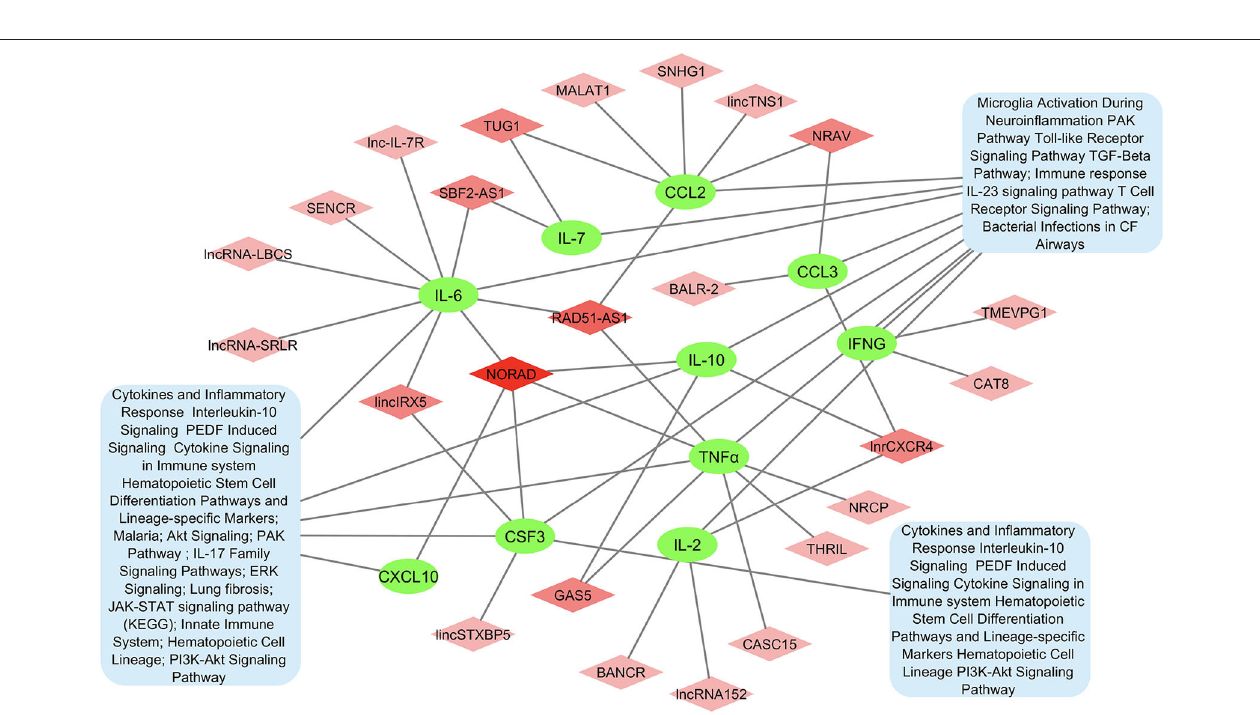
FIGURE 3 | Network of lncRNA and cytokine pathway associations for most significant cytokines in COVID-19 cytokine storm. Cytokines are shown in green, lncRNAs associated with multiple cytokines are shown in darker shades of pink, and pathways are shown in blue.